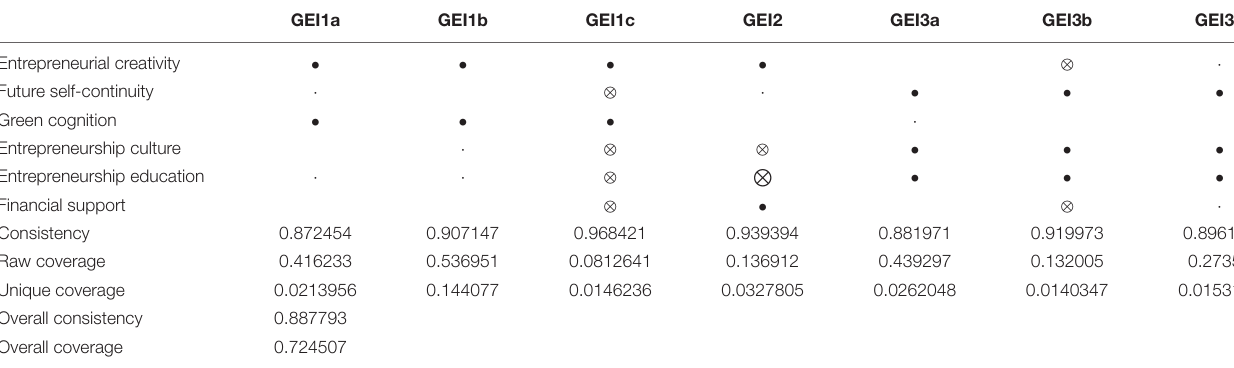
TABLE 4 | Configurations sufficient for high green entrepreneurial